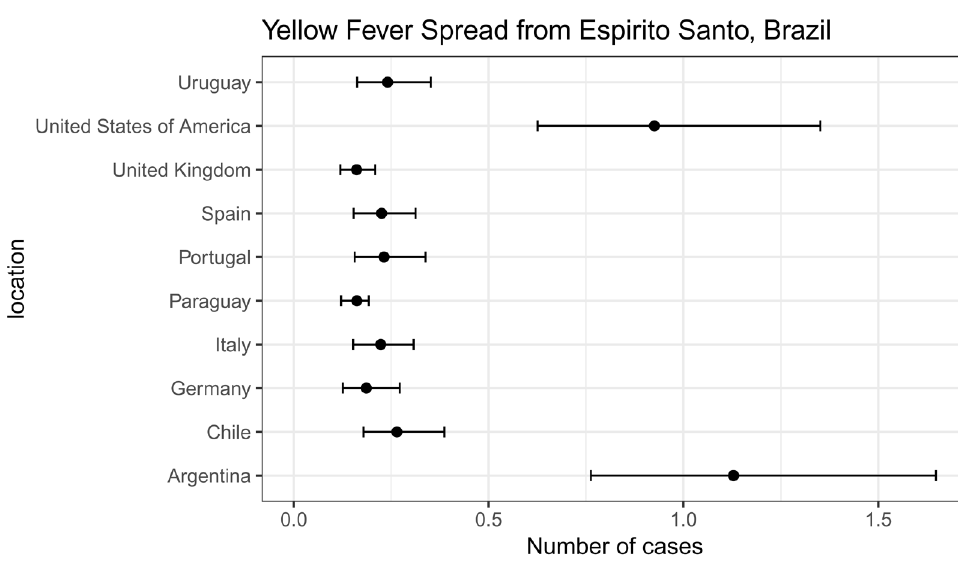
Figure 1. Mean number of yellow fever cases and 95% CI spread from Espirito Santo to other